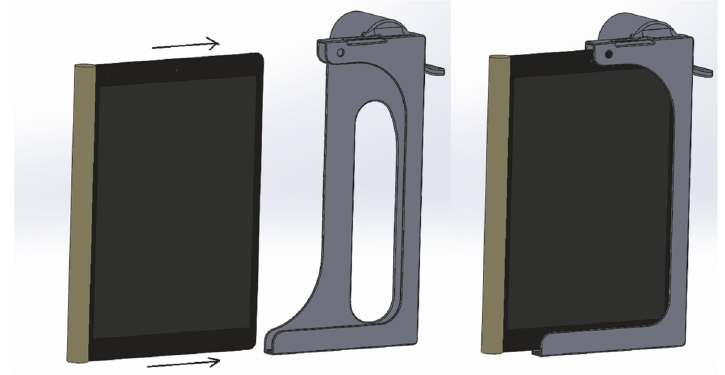
Figure 5: Sliding mechanism for the